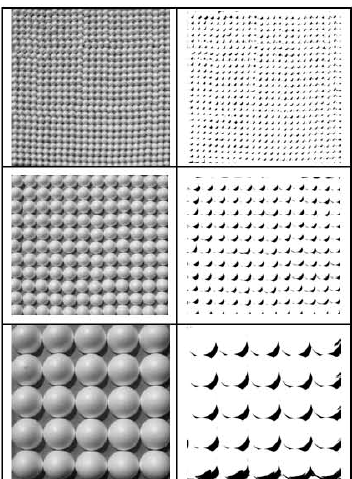
Fig. 1. Hemispheres with 40, 85 and 200mm diameters (top to bot- tom) for shadows analysis laboratory experiments including (left) images without change, and (right) black and white images used to generate the histogram with percentage of